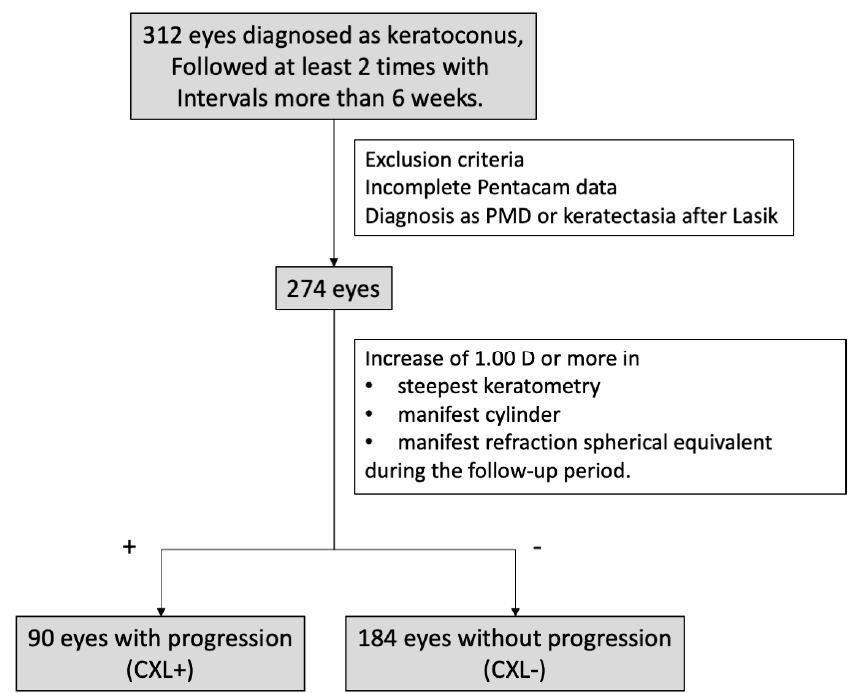
Figure 1. The flowchart representing the selection of enrolled patients. CXL: corneal crosslinking. We created an AI model to predict conical cornea progression with an axial map (Ax- using a Pentacam HR instrument; the assessments were based on patients’ age (Figure 2).